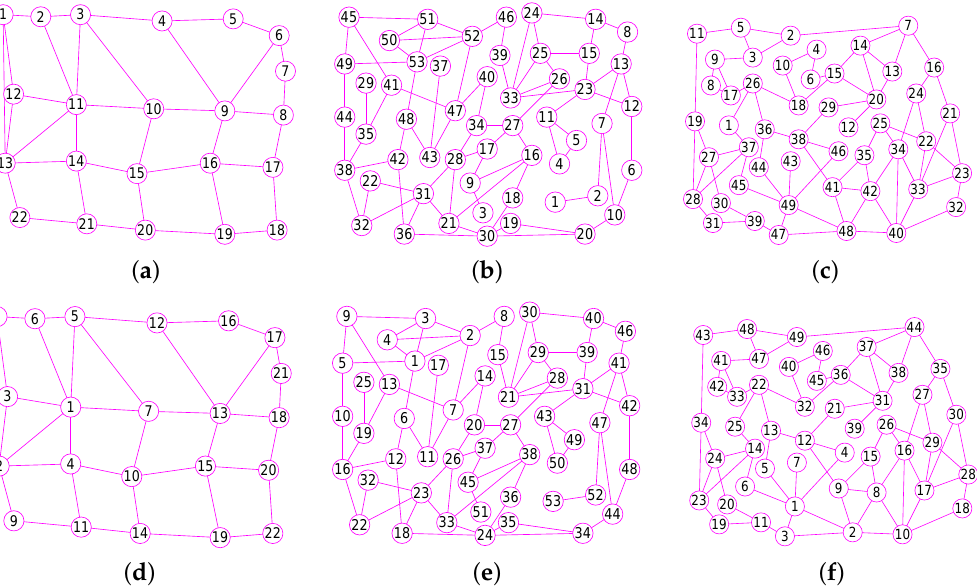
Figure 9. The TopMost graphs of three graphs G 1 , G 2 and G 3 . ( a ) A graph G 1 of 22 vertices and 37 edges; ( b ) A graph G 2 of 53 vertices and 80 edges; ( c ) A graph G 3 of 49 vertices and 78 edges; ( d ) The TopMost graph of G 1 ; ( e ) The TopMost graph of G 2 ; ( f ) The TopMost graph of G 3 .